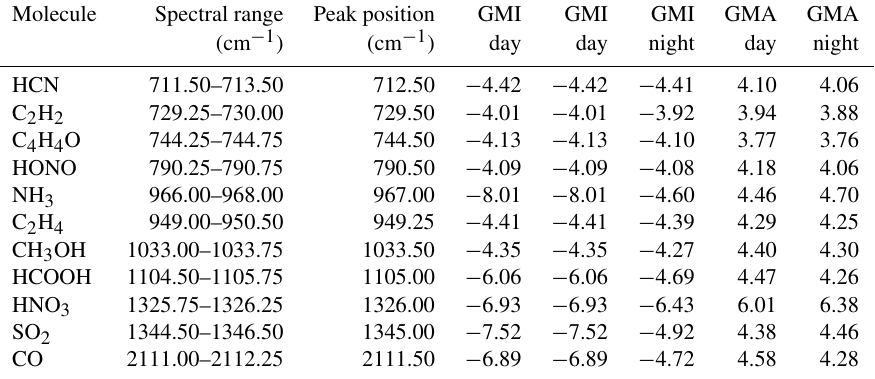
Table 1. Signal intensity thresholds ( F 2 ) for several species for day- and nighttime conditions obtained from the 99th percentile of the GMA or GMI pseudo-residuals. The thresholds are defined based on the more intense peaks associated with each molecule. Since IASI-PCA sensitivity is generally lower during nighttime than during daytime, which is mainly due to thermal contrast, different thresholds for day- and nighttime conditions were defined. Molecule Spectral range Peak